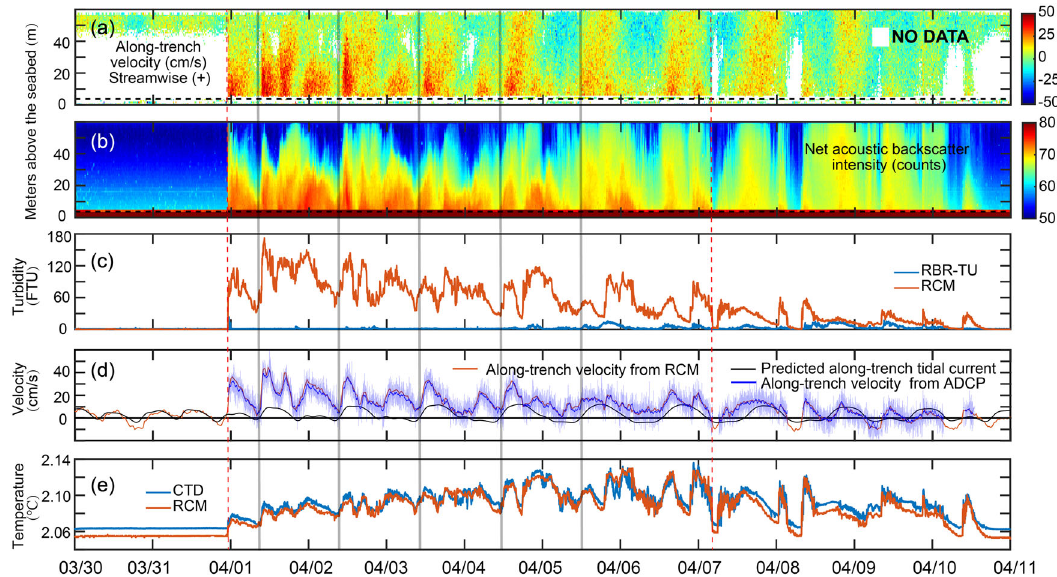
Fig. 2 Plots of the time-series measurements for the turbidity current E1 at the mooring site S2. a Along-trench current velocity (cm s − 1 ) and ( b ) net acoustic backscatter intensity (counts) (averaged over four beams) recorded by the downward-looking ADCP. The in fl uence of water attenuation and spherical spreading had been corrected. The area under the black dashed line was affected by the side lobe interference. c Time-series of turbidity measured by the RBR-TU at 72 MAB (blue line) and by the turbidity sensor of RCM at 12 MAB (orange line). d Along-trench current velocity (cm s − 1 ) measured by the RCM at 12 MAB (orange line), along-trench current velocity at 12 MAB recorded by the downward-looking ADCP (dark blue line), and predicted along-trench tidal current velocity (black line). e Time-series of temperature measured by CTD at 17 MAB (blue line) and by the sensor of RCM at 12 MAB (orange line). The red dashed lines indicate the beginning and end of the turbidity current.